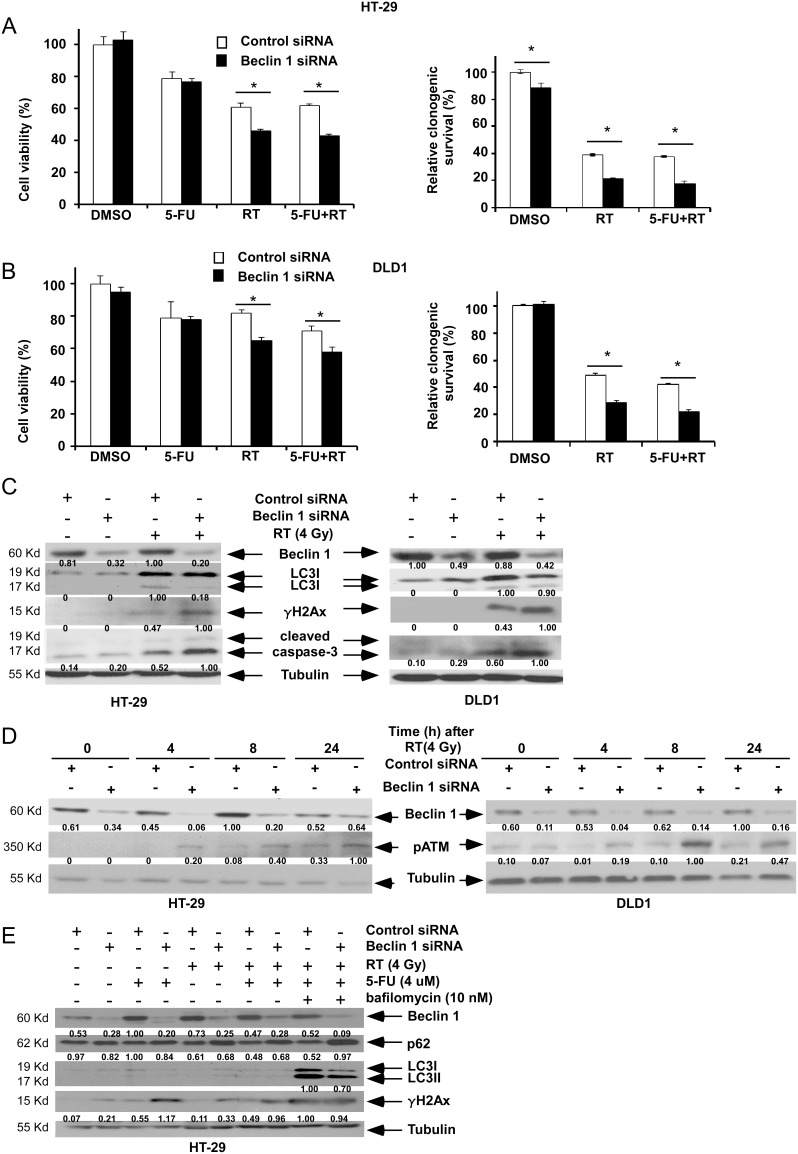

Beclin 1 suppression enhances radiation-induced DNA damage and cell death.
A, B, HT-29 (A) or DLD1 (B) cells were transfected with Beclin 1 vs control siRNA and treated with radiation (RT; 4 Gy) alone or combined with 5-FU (2 µM). Results of the MTS (24 h) and clonogenic survival assays are shown. Data are presented as mean ± standard deviation for experiments performed in triplicate. Statistical significance was determined by a two-sided Student’s t test and defined as *P<0.05. C, Cells with Beclin 1 or control siRNA were irradiated (4 Gy) and then were probed for expression of LC3I-II, γH2Ax, and cleaved caspase-3 by immunoblotting at 24 h. Protein bands are quantified and relative intensity was labelled underneath the corresponding blot. Only LC3II was quantified for LC3 protein. D, Time course of the effect of radiation on pATM expression in cells with Beclin 1 siRNA vs control siRNA. E, Effect of Beclin 1 siRNA on autophagic flux in cells that were treated with RT (4 Gy) and/or 5-FU (4 µM).